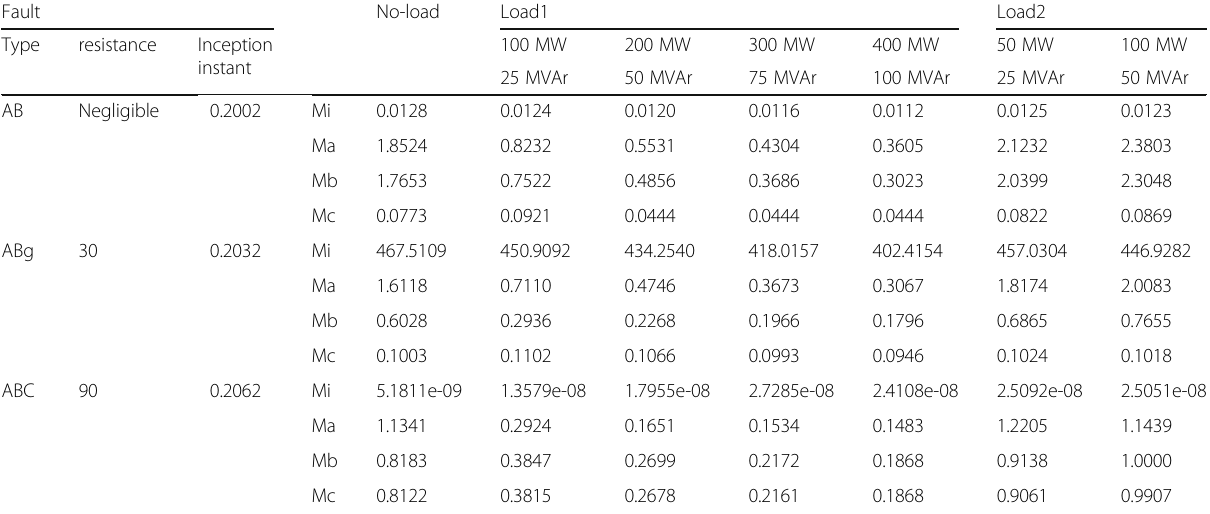
Table 6 Results of various load levels